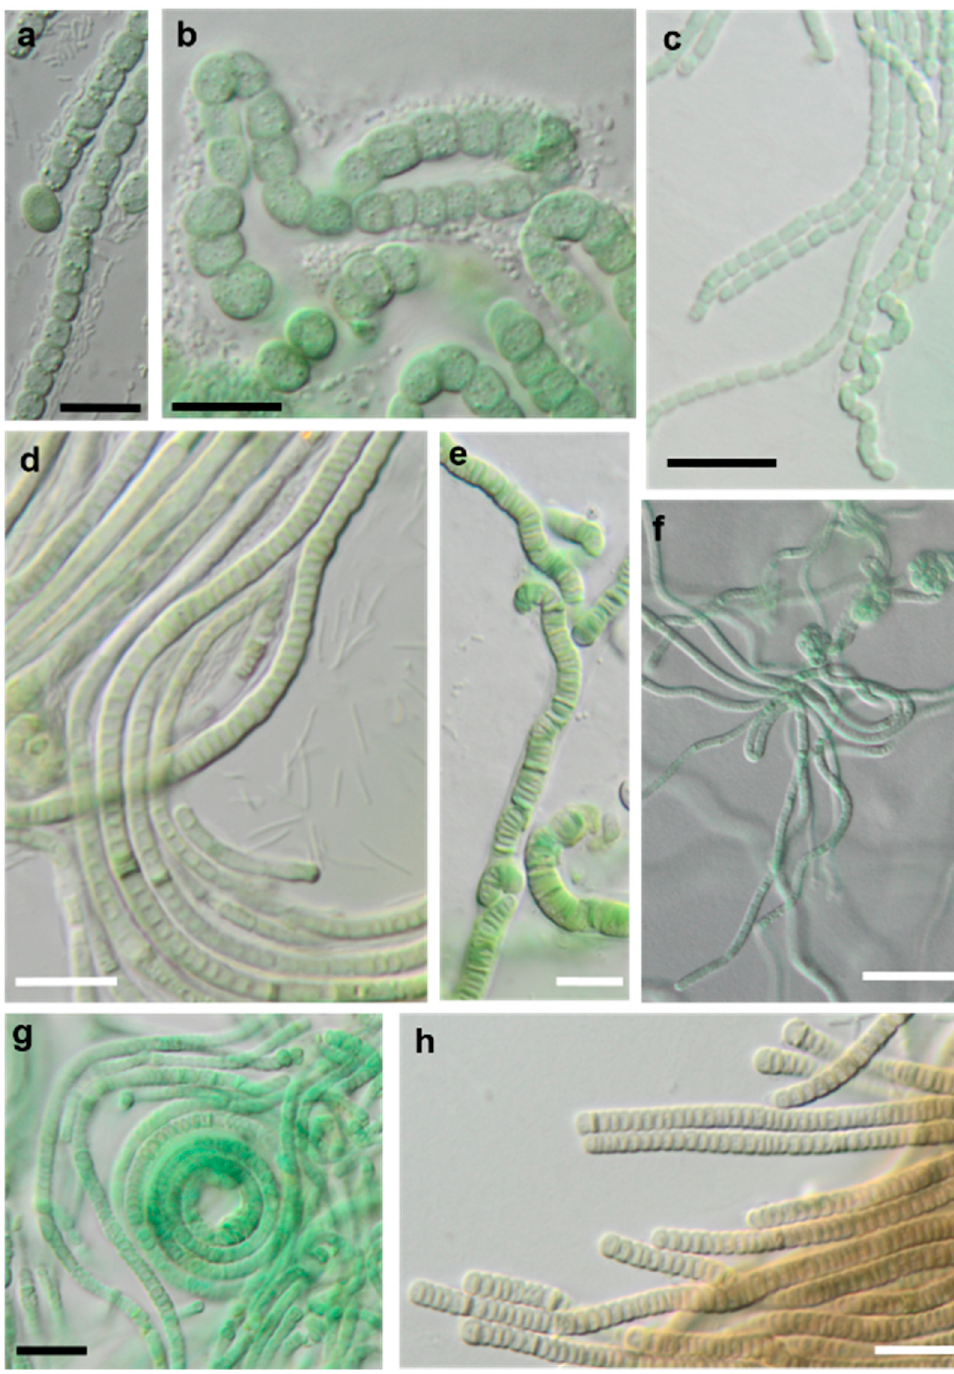
Figure 18. Photomicrographs of cyanobacteria isolates: ( a , b ) Nostocales and ( c – h ) Synecchococcales. ( a , b ) Cyanocohniella sp. SY-1-2-Y, ( c ) Nodosilinea cf. signiensis NN-3-1-CD, ( d ) “P hormidesmis ” sp. NN-3-1-CA, ( e ) “ Pseudophormidium ” battersii NN-3-1-D, ( f ) Nodosilinea cf. signiensis NN-2-1-EE, ( g ) Nodosilinea bijugata OD-1-1-T, and ( h ) “ Pseudophormidium ” battersii NN-3-1-B. Black scale bars: 10 µm and white scale bars: 20 µm.